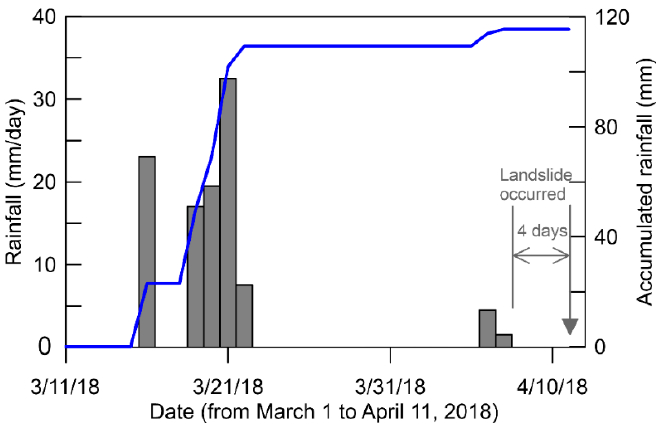
Figure 7. Nakatsushi rainfall station data prior to the landslide event.